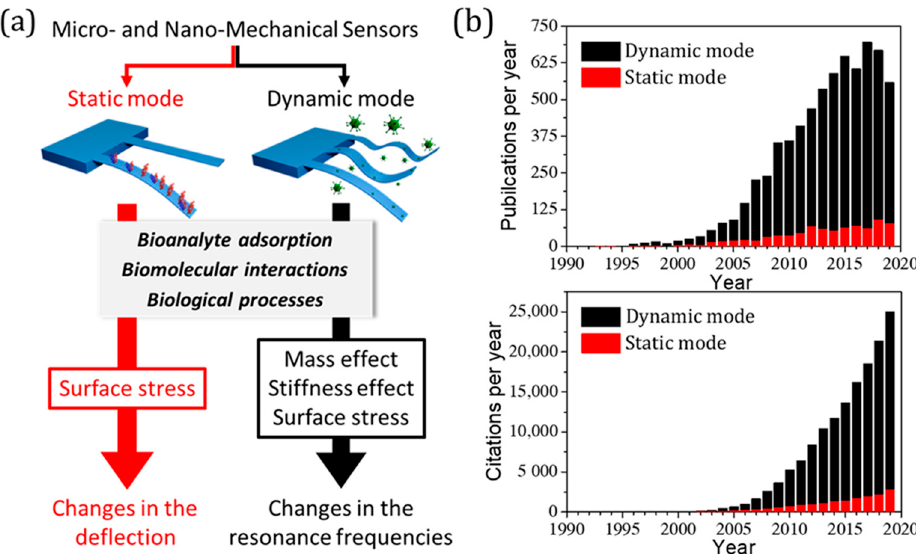
Figure 1. ( a ) Schematic depiction of the two different operation modes, static and dynamic, in which a nanomechanical sensor can function, showing their basic principle of operation when used for biological applications. ( b ) Chronogram of the publication and citation rate in the nanomechanical sensing field, focused on biological applications, and splitting them into static (red) and dynamic (black) operation modes.